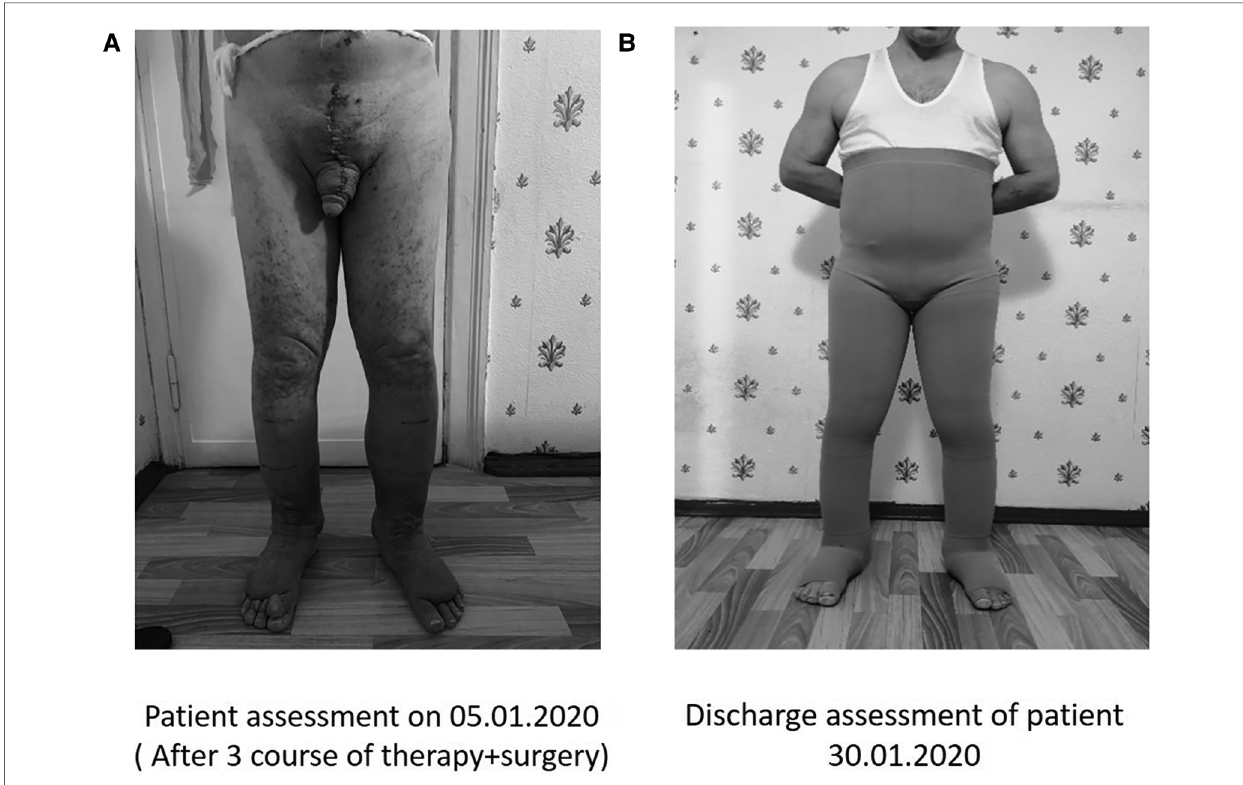
FIGURE 4 The patient ’ s conditions a month after surgery (January 05, 2020, A ) and at the time of discharge (January 30, 2020, B ). Patient wearing the compression knitwear fl at knitting Mediven 550, made according to individual standards — leggings of 2 compression class, socks of 3 compression class, product on the foot of 3 compression class on the left lower limb, stockings of 3 compression classes.